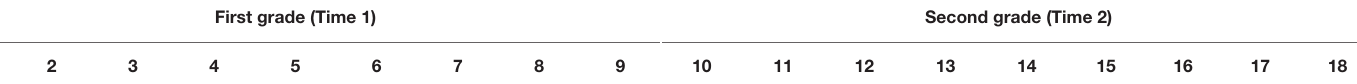
TABLE 1 | Descriptive statistics and